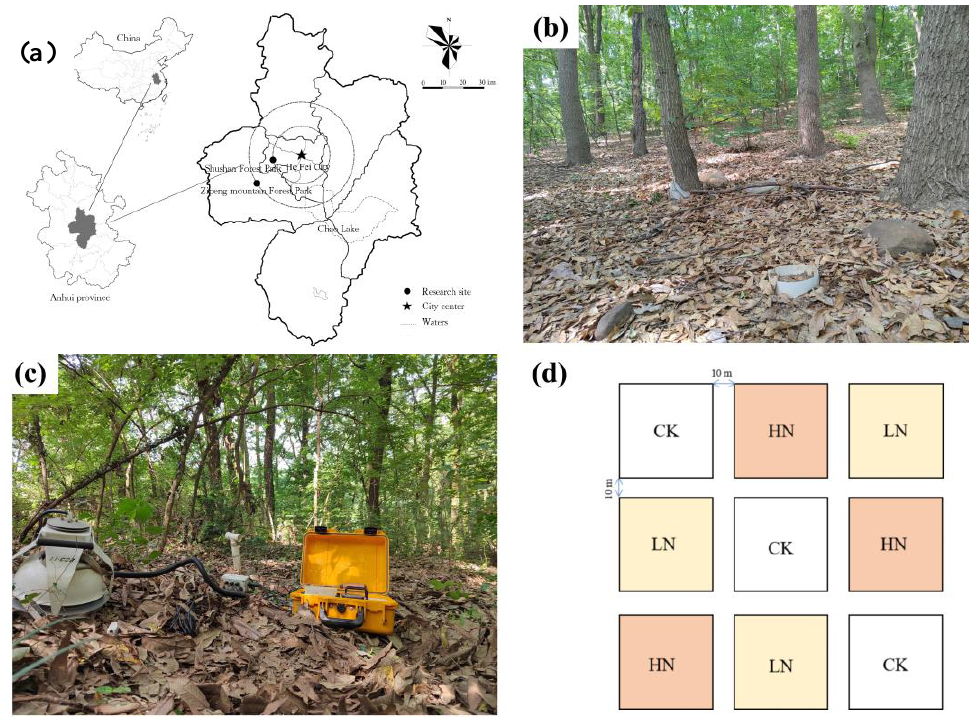
Figure 1. Study area in Hefei City, Anhui Province, China: ( a ) overview of the periurban forest; ( b ) overview of the outskirt forest; ( c ) schematic of the experimental plots ( d ). Table 1. Basic features of the experimental plots.